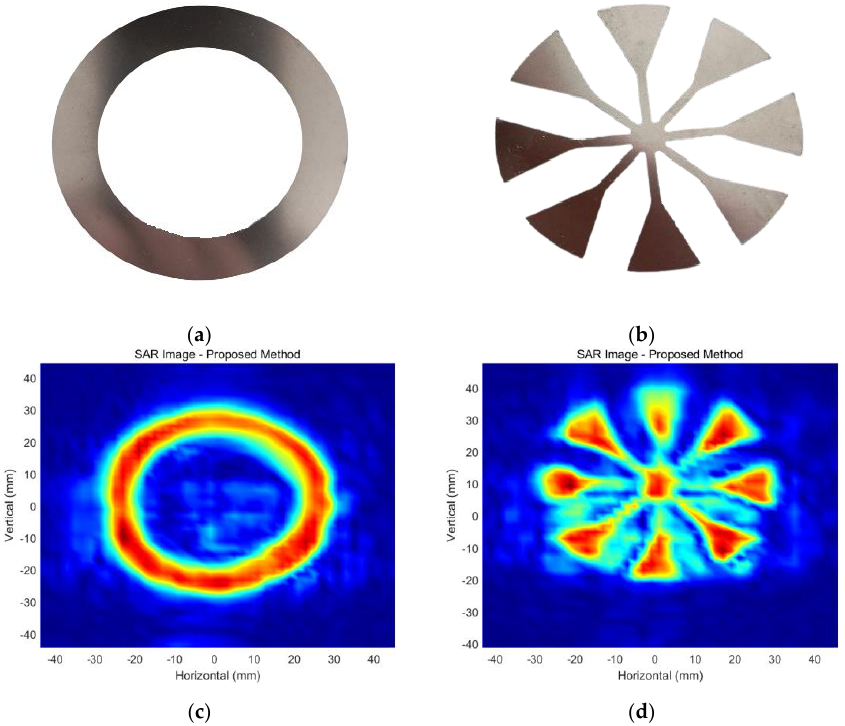
Figure 6. Fully-sampled experiment: ( a ) Optical image of circle target; ( b ) Optical image of star target; ( c ) Imaging result of circle target; ( d ) Imaging result of star target.